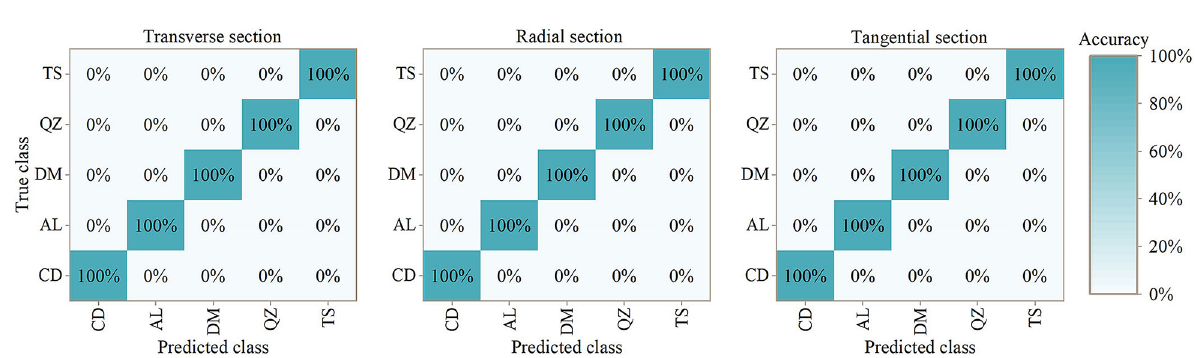
Figure 7. Mixing matrix for results of five Guiboutia species with SVM model. CD = G. conjugate ; AL = G. ehie ; DM = G. demeusei ; QZ = G. coleosperma ; TS = G. tessmannii .